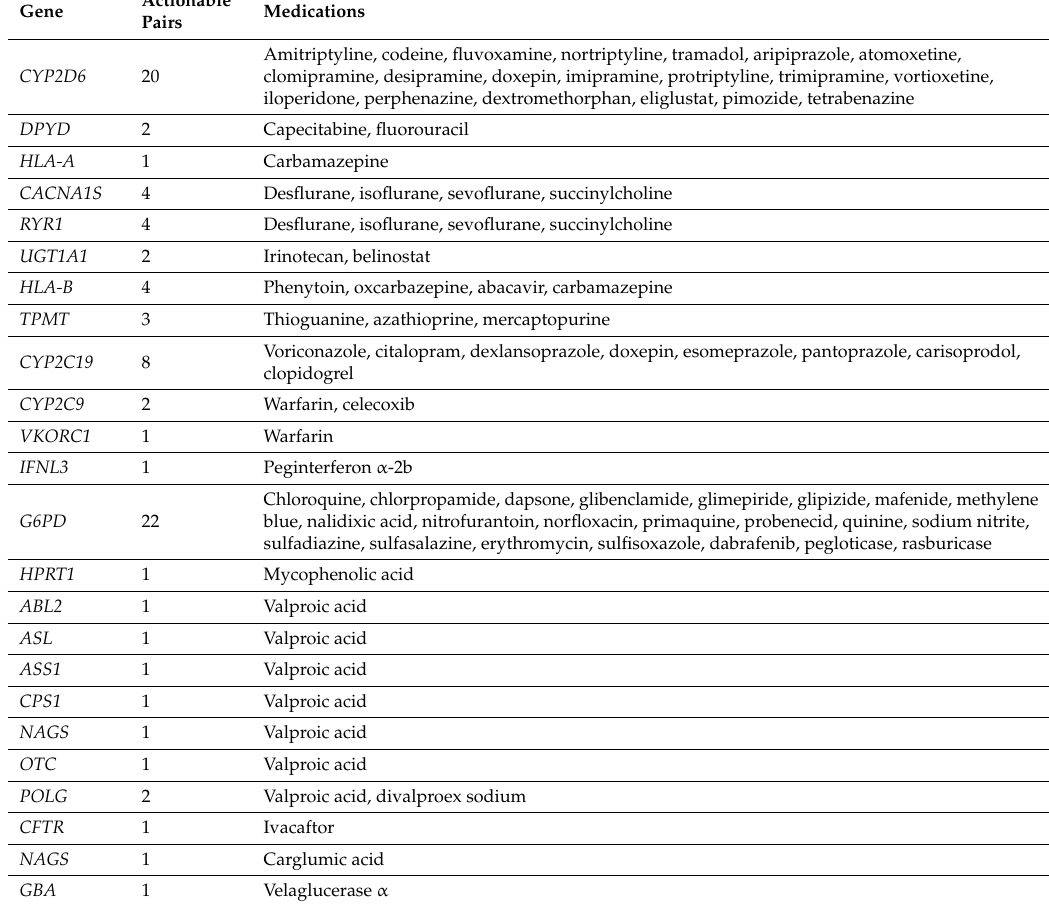
Table 1. Overview of actionable pharmacogenetic gene–drug pairs. Data obtained from reference [8]. In total, 86 actionable gene drug pairs (24 unique genes and 73 unique drugs) are listed for which a change in prescribing is recommended based on genetic makeup of the patient (Actionable label and CPIC levels A or